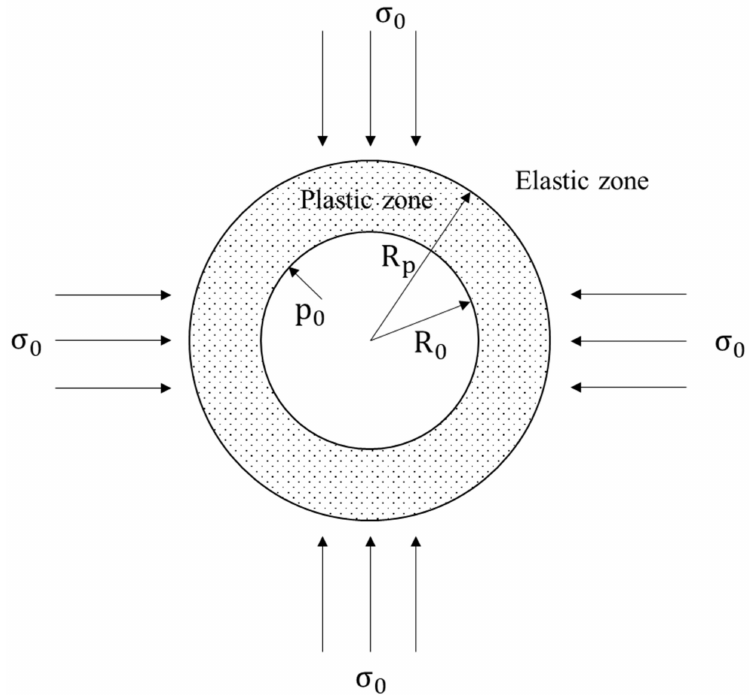
Figure 11. Mechanical model of hard rock shaft.